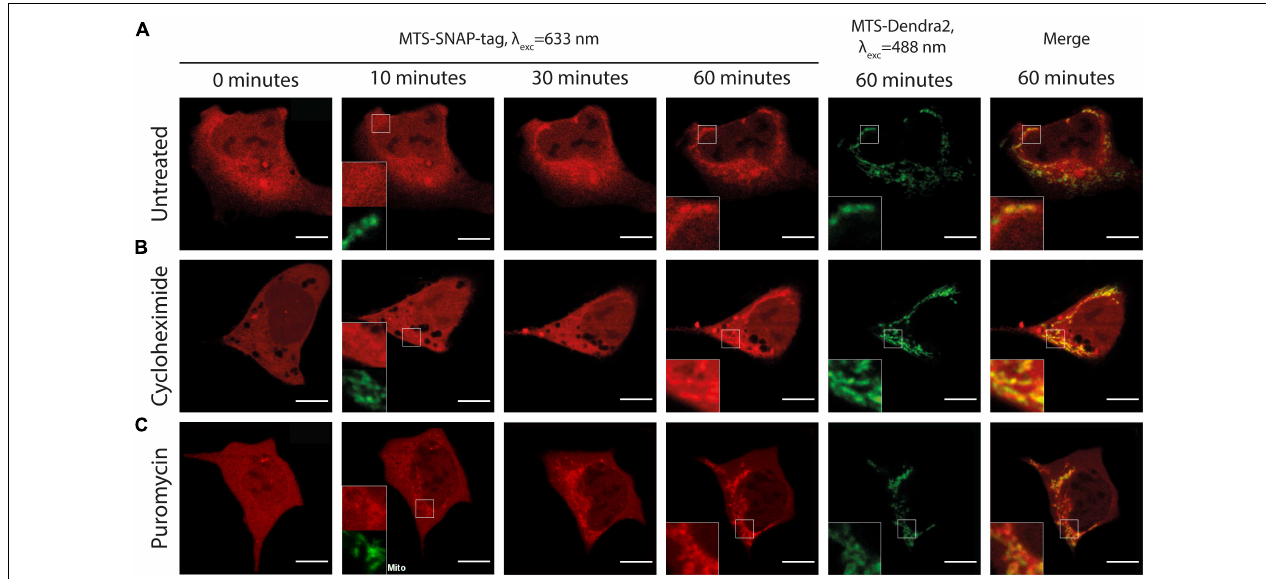
FIGURE 4 | Time-lapse microscopy of the microinjected MTS-SNAP-tag protein (red) import into the mitochondria in HEK293 MTS-Dendra2 (green) cells under different conditions. (A) Untreated HEK293-MTS-Dendra2 cells. After 10 min, no noticeable MTS-SNAP-tag protein accumulation in the mitochondria can be seen (shown enlarged in the inset). MTS-SNAP-tag protein accumulation is seen after 60 min. (enlarged region in the insets). (B) HEK293-MTS-Dendra2 cell treated with 100 µ g/ml CHX. After 10 min, no noticeable MTS-SNAP-tag protein accumulation in the mitochondria can be seen (shown enlarged in the inset). The MTS-SNAP-tag protein accumulation is seen similarly to the untreated cells (enlarged region in the insets) after 60 min. (C) HEK293-MTS-Dendra2 cell treated with 20 µ g/ml PUR. After 10 min, MTS-SNAP-tag protein accumulation in the mitochondria can be seen (shown enlarged in the inset). After 60 min, the MTS-SNAP-tag protein accumulation results in brighter mitochondria as compared to the CHX-treated and untreated cells. Scale bars 10 µ